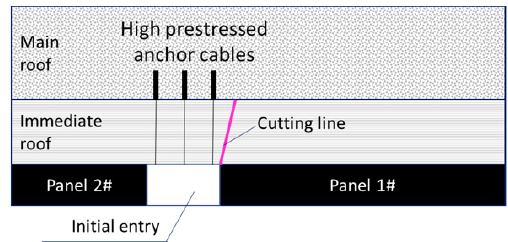
Figure 1. Layout of working faces and roadways for the GERRC.